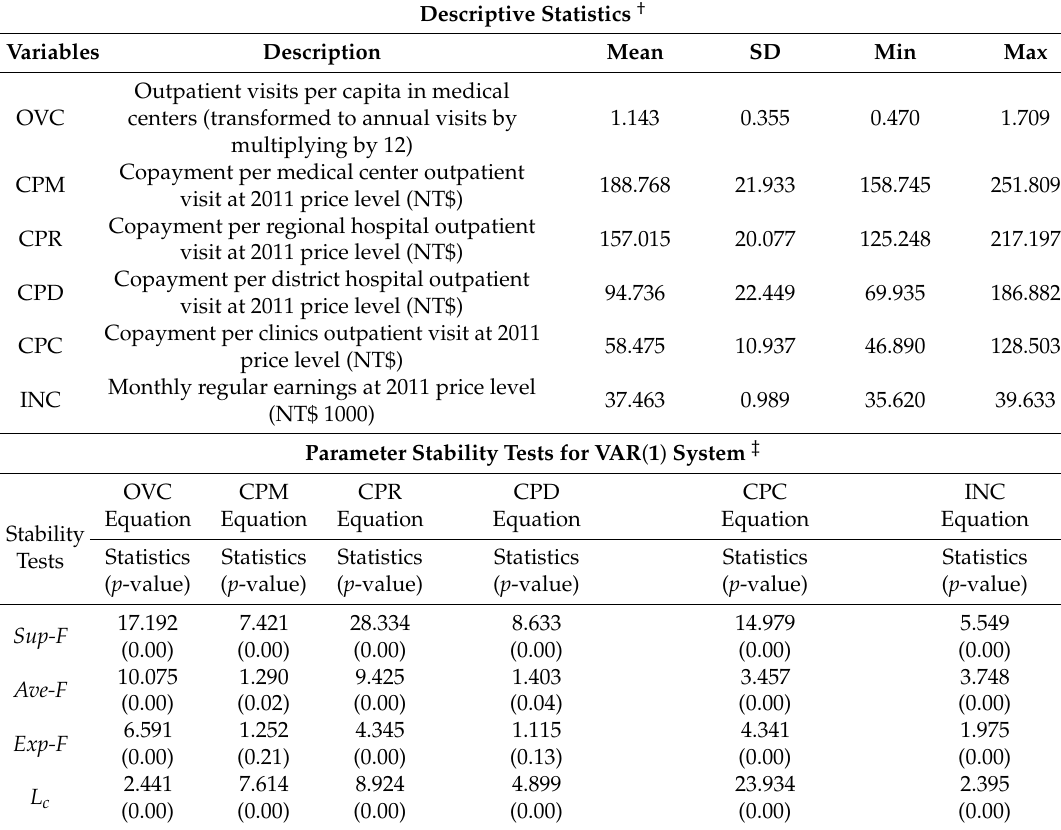
Table 1. Parameter stability tests for the time-varying parameter vector autoregressive